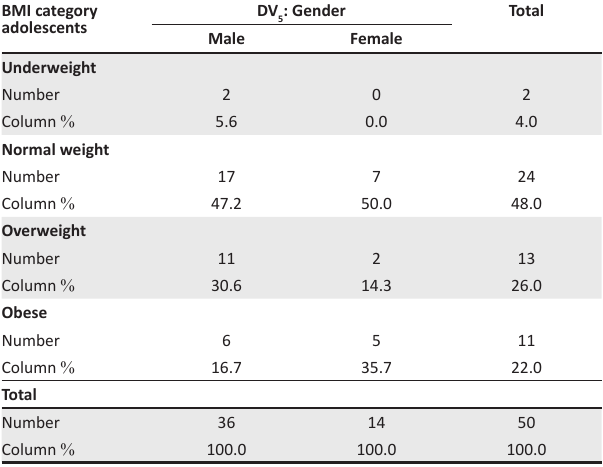
TABLE 1: Body mass index categories for both